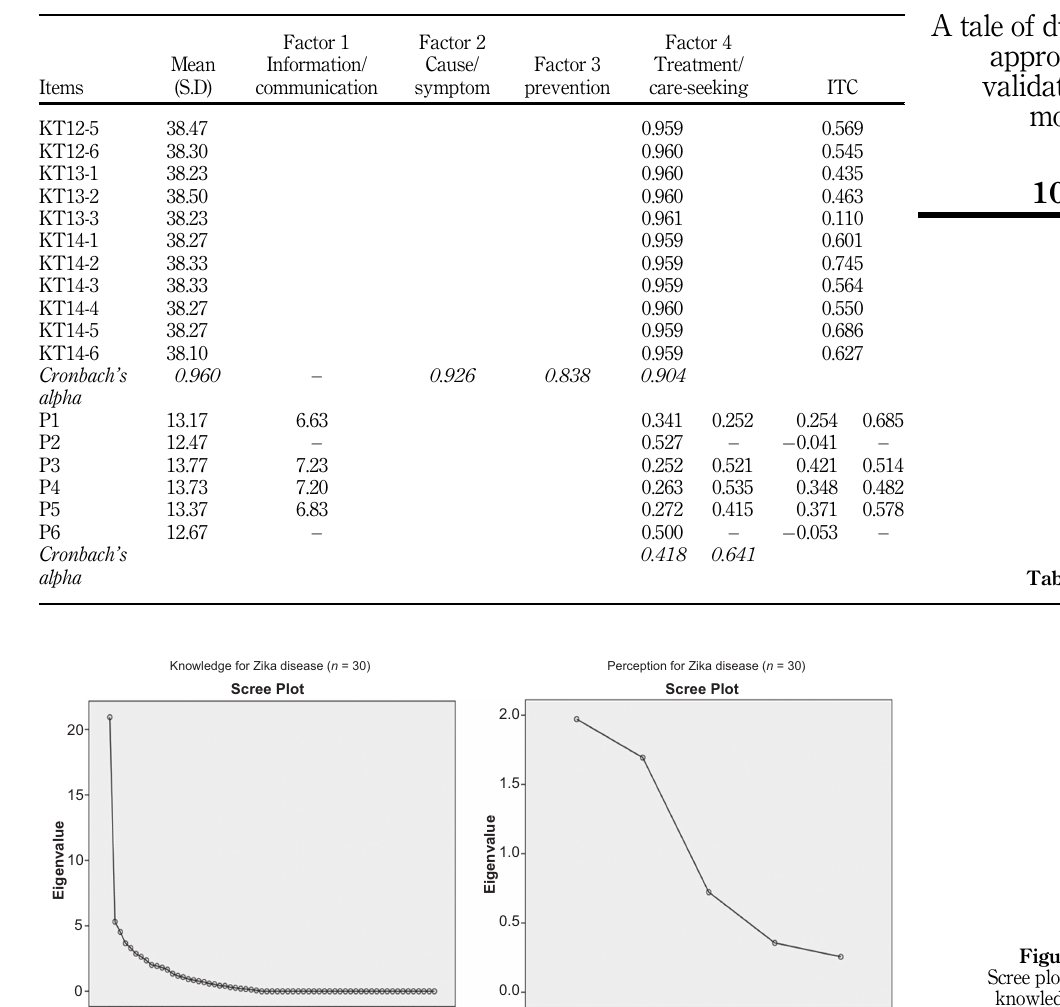
Figure 2. Scree plots